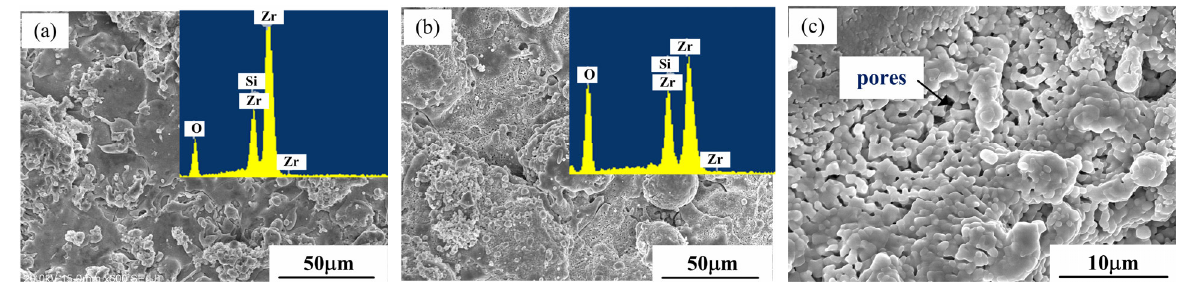
Fig. 7 Surface morphology of the ZrSiO 4 coating (a) before and (b) after corrosion and (c) magnified of (b). Table 2 Ratio of Si and Zr in ZrSiO 4 coating at different corrosion time 3. 3 Recession mechanism of ZrSiO